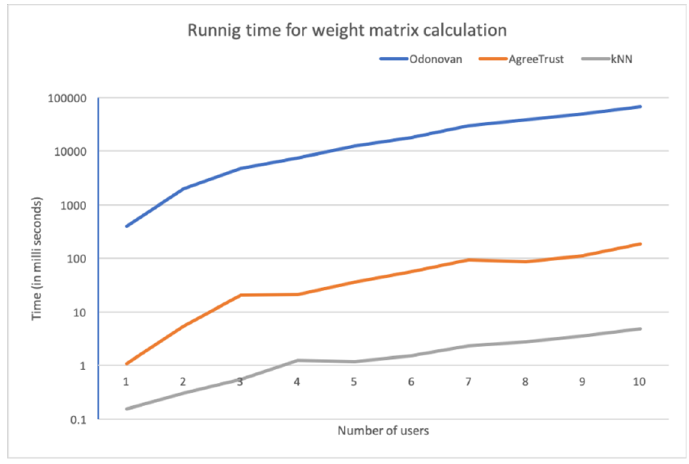
Figure 6. Running time to calculate weight matrices.